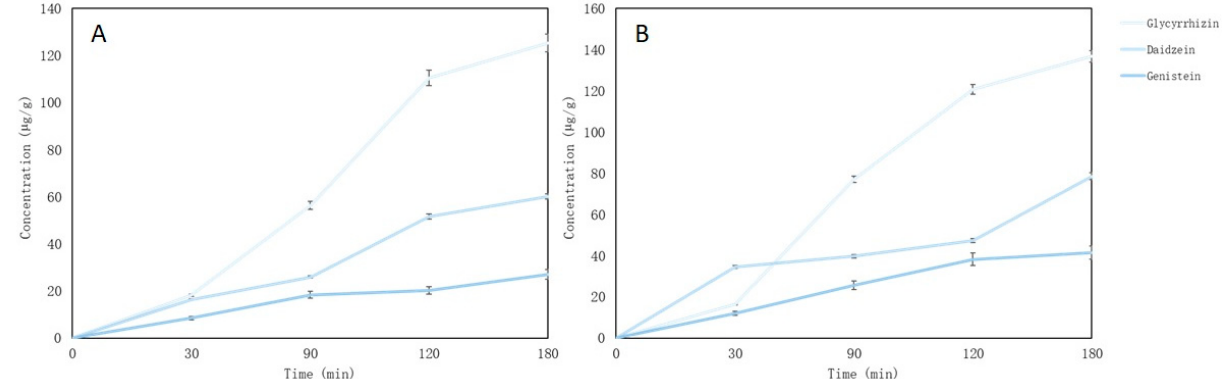
Figure 6. Isoflavones and saponin release from nutmeg essential oil-loaded lyophilized microcapsules (%); ( A ) gelatin gel tablets; ( B ) pectin gel tablets.